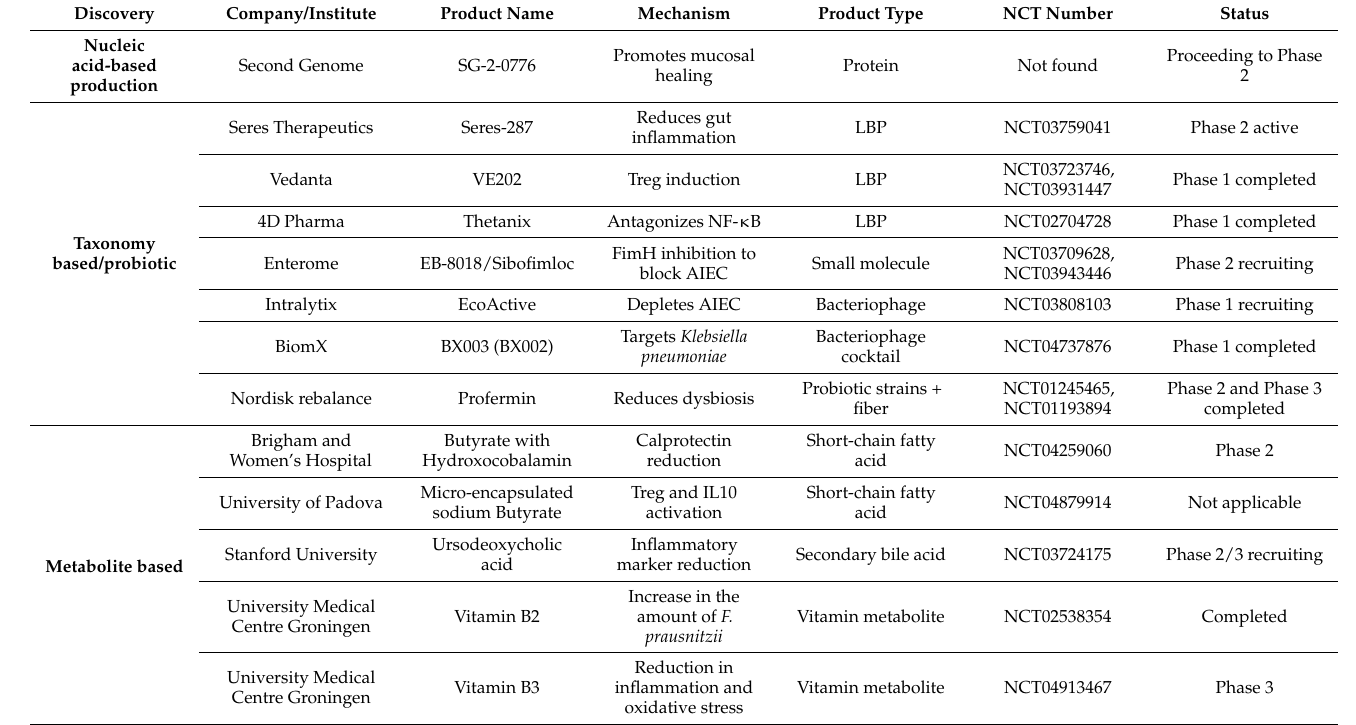
Table 1. Overview of microbiome-derived therapeutic candidates undergoing clinical